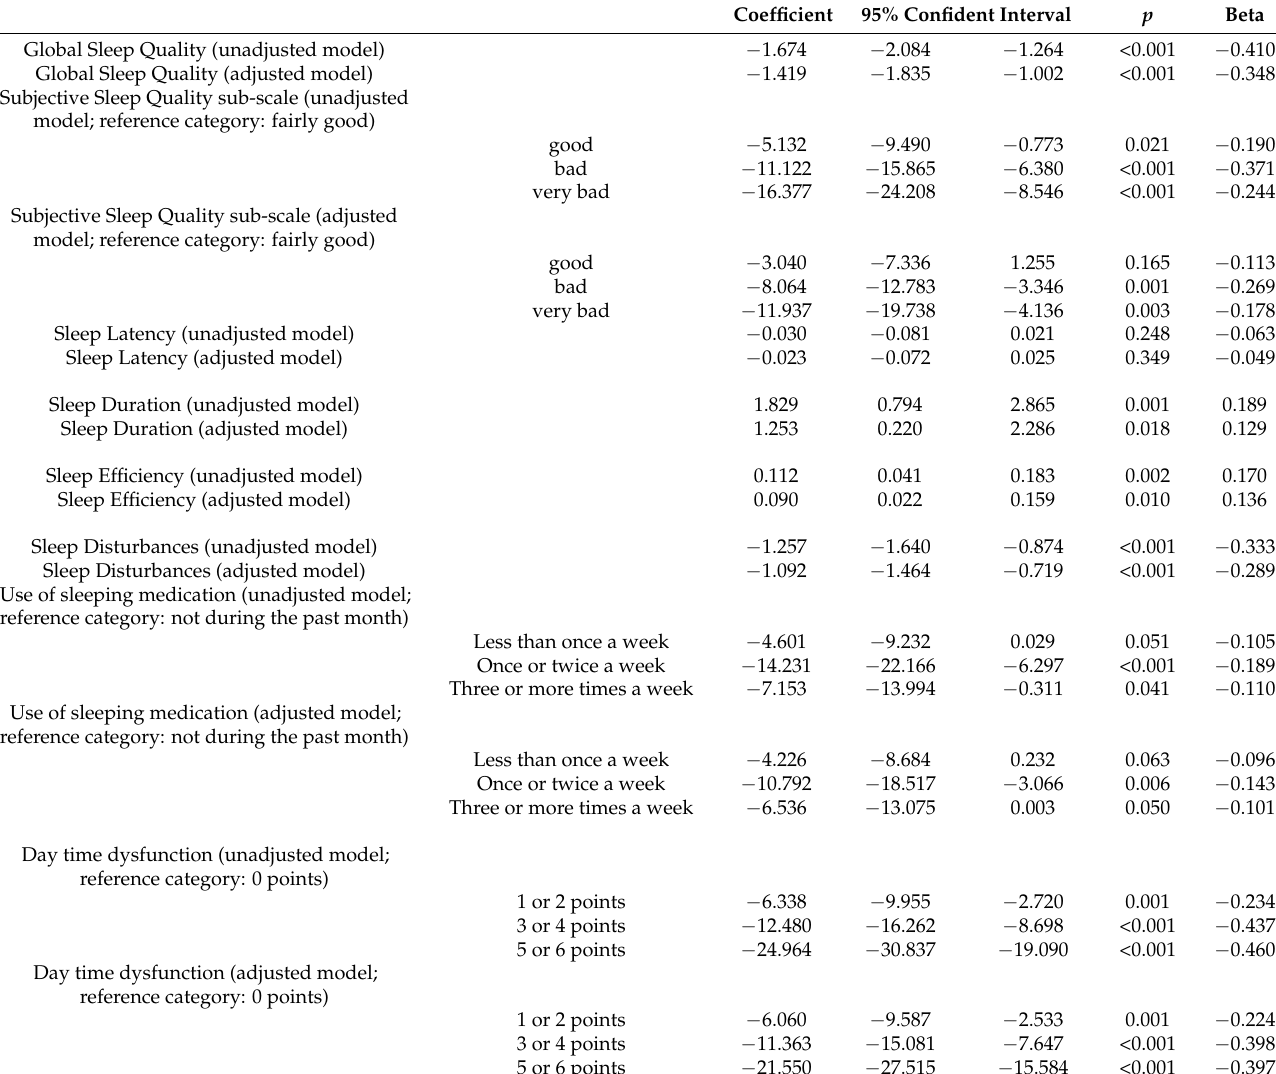
Table 3. Sleep quality and mental health (outcome variable: mental health). Coefficient 95% Confident Interval p